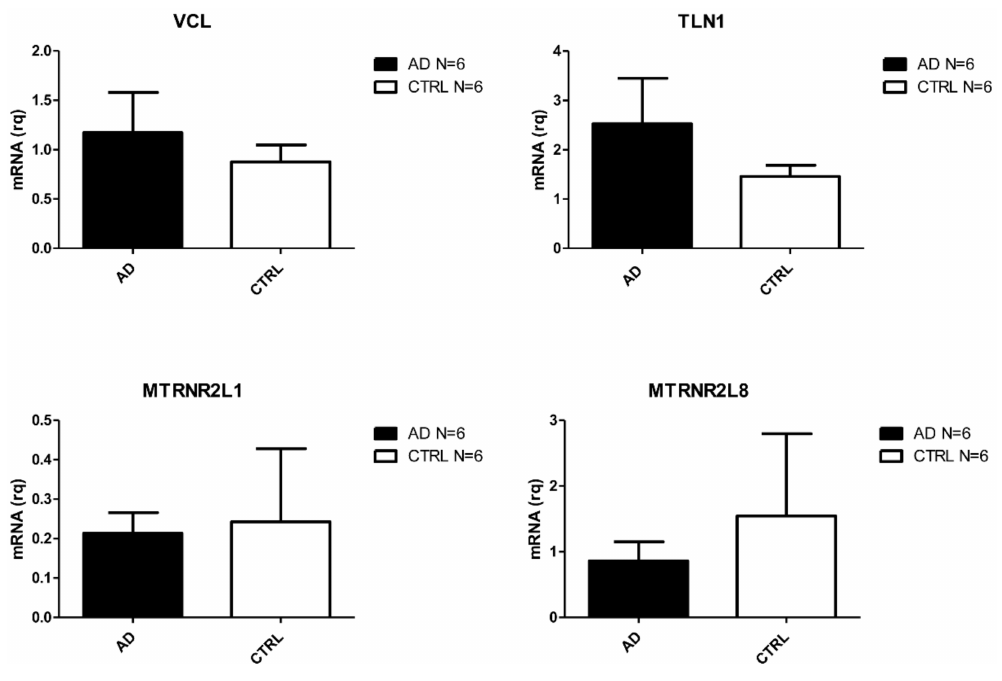
Figure 3. Di ff erentially expressed transcripts verified by Real Time PCR in PBMC from AD and CTRs (N = 6).